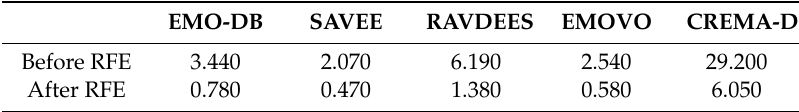
Table 10. Training time (ms) of RALOG on individual